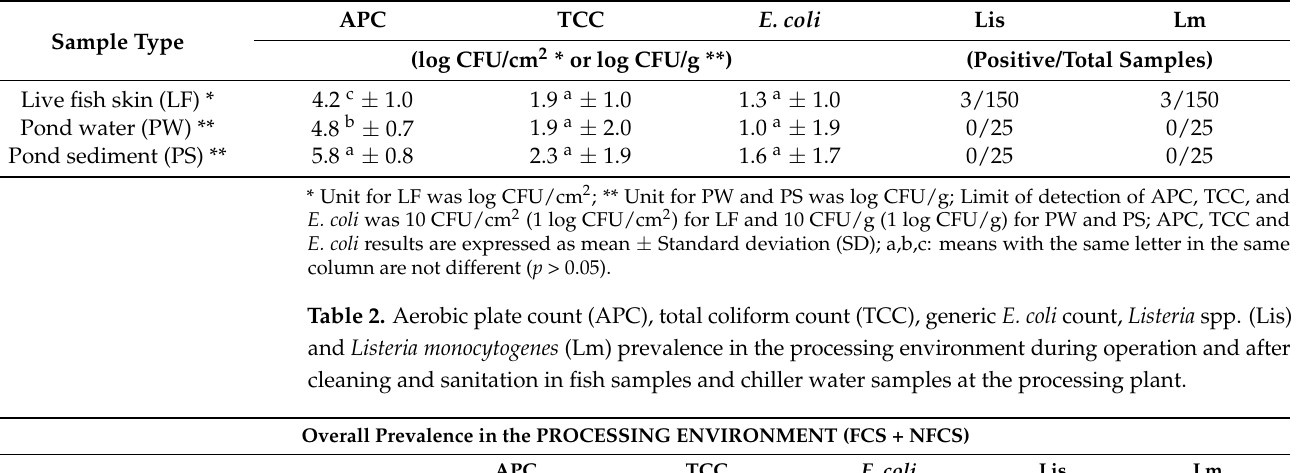
Table 1. Aerobic plate count (APC), total coliform count (TCC), generic E. coli count, and Listeria spp. (Lis) and Listeria monocytogenes (Lm) prevalence on live fish skin, pond water, and pond sediment.